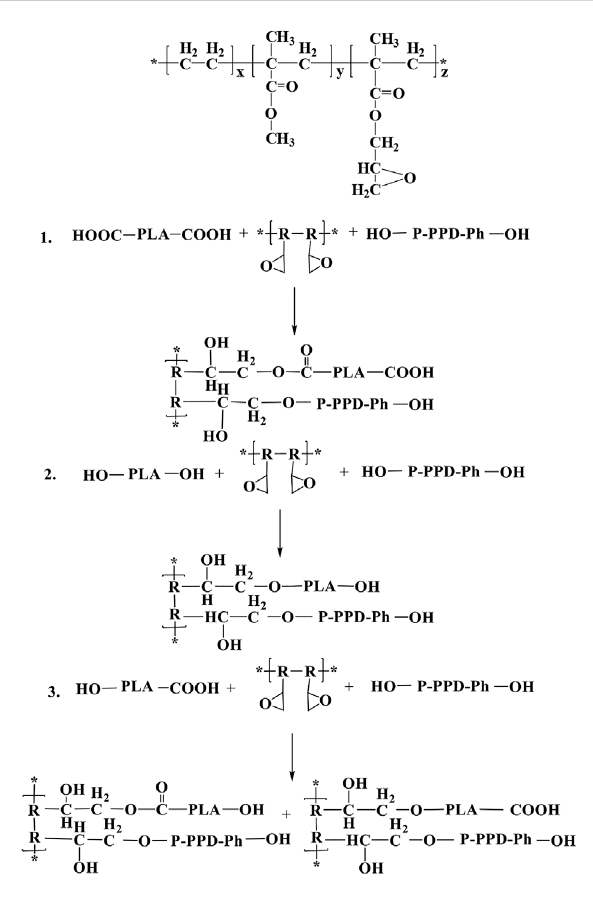
FIGURE 5 Structural formula ofECE and major chemical reactions that may occurinPLA/ECE/P-PPD-PhConjugated fl